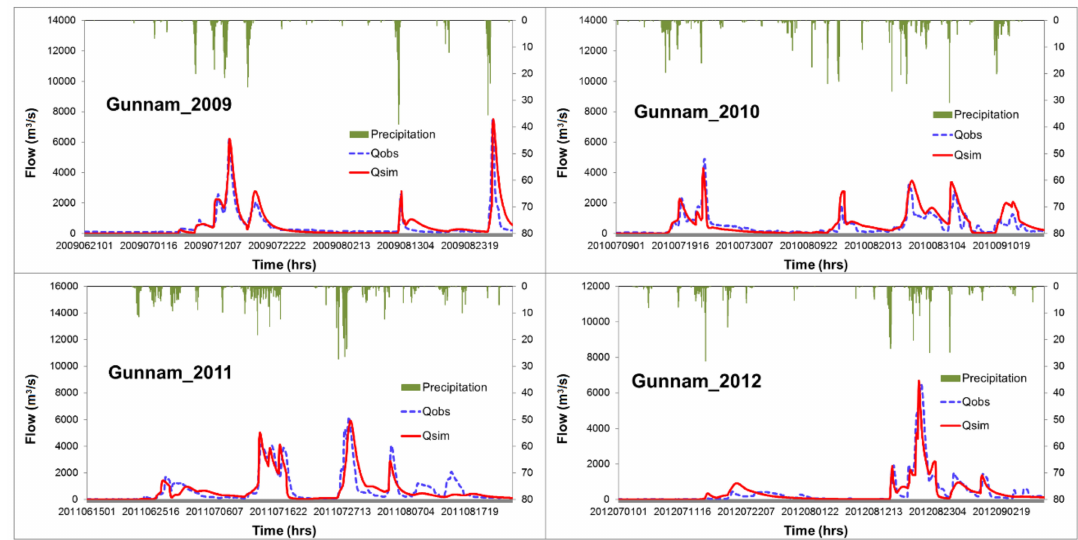
Figure 3. The simulated and observed discharges at Gunnam station in 4 flood events (2009, 2010, 2011, and 2012) after considering dam impact.